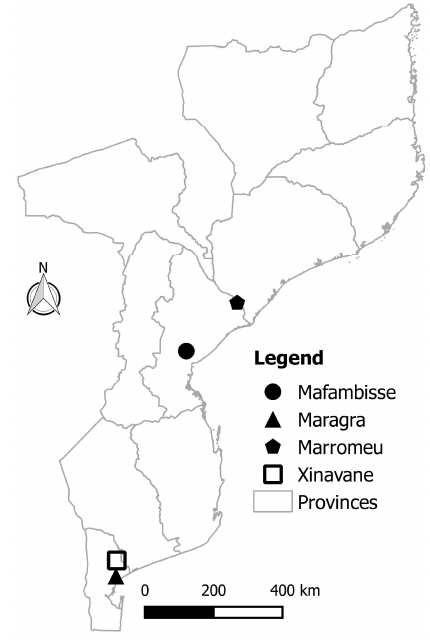
Figure 2. Sugarcane mills in Mozambique.